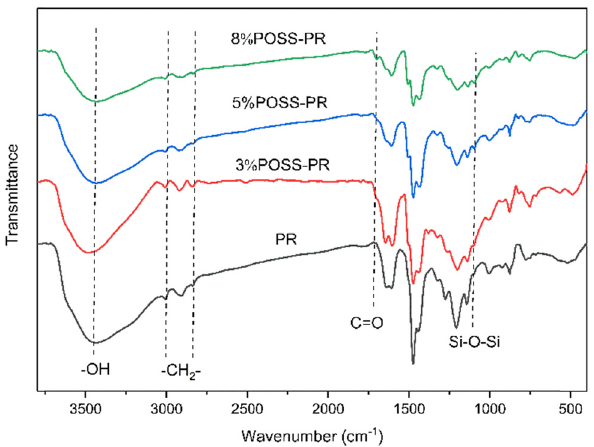
Figure 8: FTIR spectra of cured product of PR, 3% POSS - PR, 5% POSS - PR, and 8% POSS -